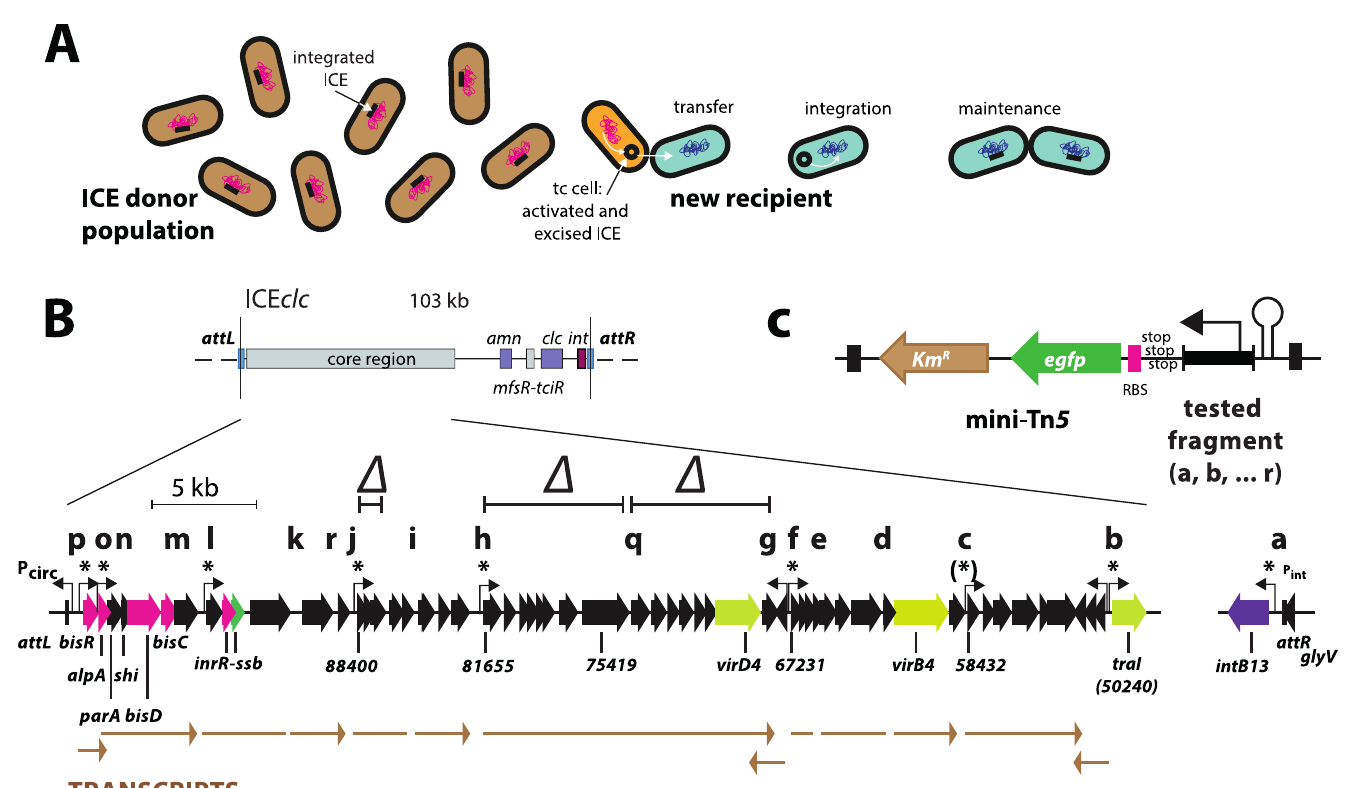
Fig 1. ICE clc life-style and transfer competence development. A Chromosomally-integrated ICE (black bar, schematically) activates and excises in rare transfer competent cells (tc, black circle; cell highlighted in orange), and transfers by conjugation to a new recipient (here in blue shading), where it inserts site-specifically and maintains through chromosomal replication. B Integrated ICE clc is delineated between the two attachment ( att ) sites (vertical lines). Layout shows the location of the core region relative to the integrase gene, the variable gene region with the clc genes for chlorocatechol and amn for 2-aminophenol metabolism, and the key regulator genes mfsR-tciR . Gene map below shows individual core genes (black and colored arrows, relevant gene names underneath), previously Northern-mapped transcripts and their orientation (in brown), fragments tested for promoter studies (letters on top) and hooked arrows pointing to identified promoters (P 58432 being inconclusive). Asterisks point to those promoters being expressed in tc cell subpopulations. Regions indicated with a Δ denote deletions for transfer studies. C General strategy of single copy chromosomally delivered individual or paired promoter-fluorescent gene reporter fusions using mini-transposon delivery.